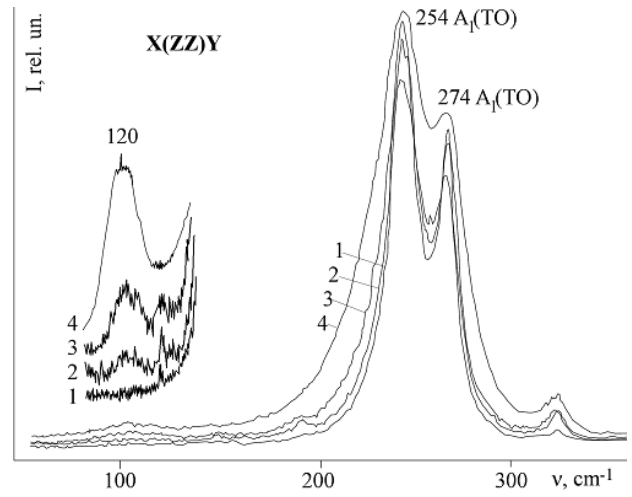
Figure 20. Fragments of the Raman spectrum of LN single crystals of different composition in the low-frequency region: 1 - SLN; 2 - SLN(K 2 O); 3 - SLN (4.5 wt.% K 2 O); 4 - CLN. The figure is reproduced with the permission of Pleiades Publishing, Ltd. from the paper Cryst. Rep., 2010, V. 55, P. 1019-1024, doi 10.1134/S1063774510060192.